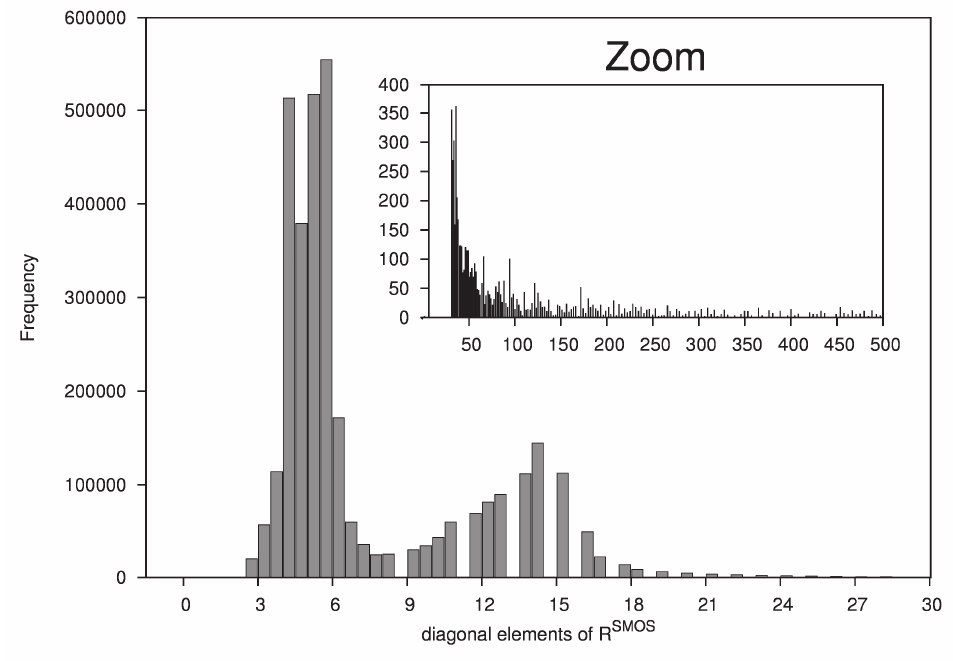
Figure 2. Histogram of the diagonal elements of the R SMOS matrix defined in Equation (4). Only SMOS observations assimilated at 40 ◦ incidence angle and XX and YY